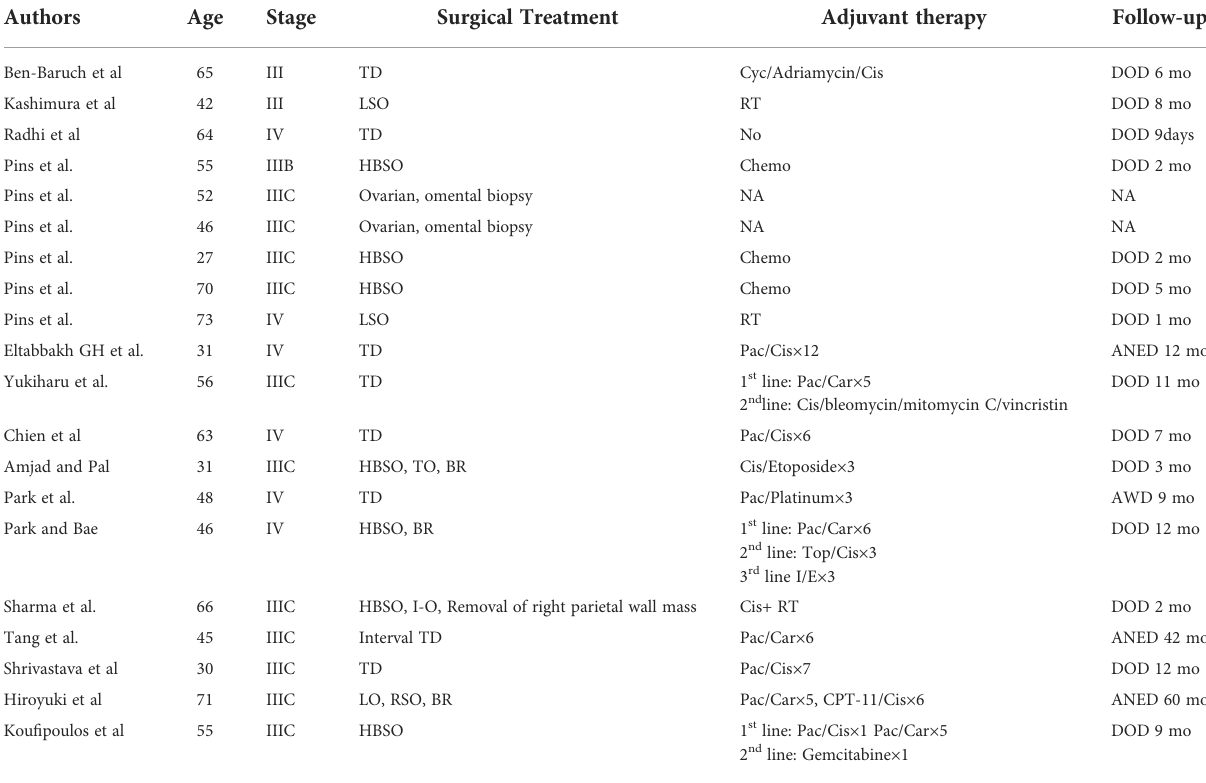
TABLE 1 Summary of literature-based papers referring to advanced-stage pure primary oSCC.